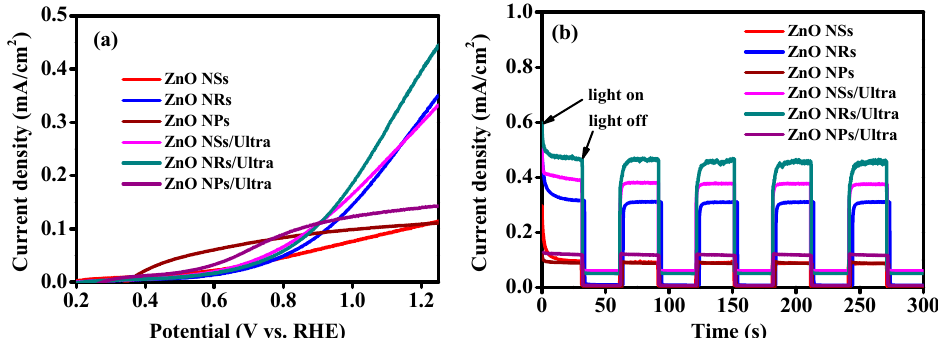
Figure 7. ( a ) Photocurrent density-voltage curves and ( b ) current density-time curves of three samples and three samples with ultrasonic vibrations (Ultra).